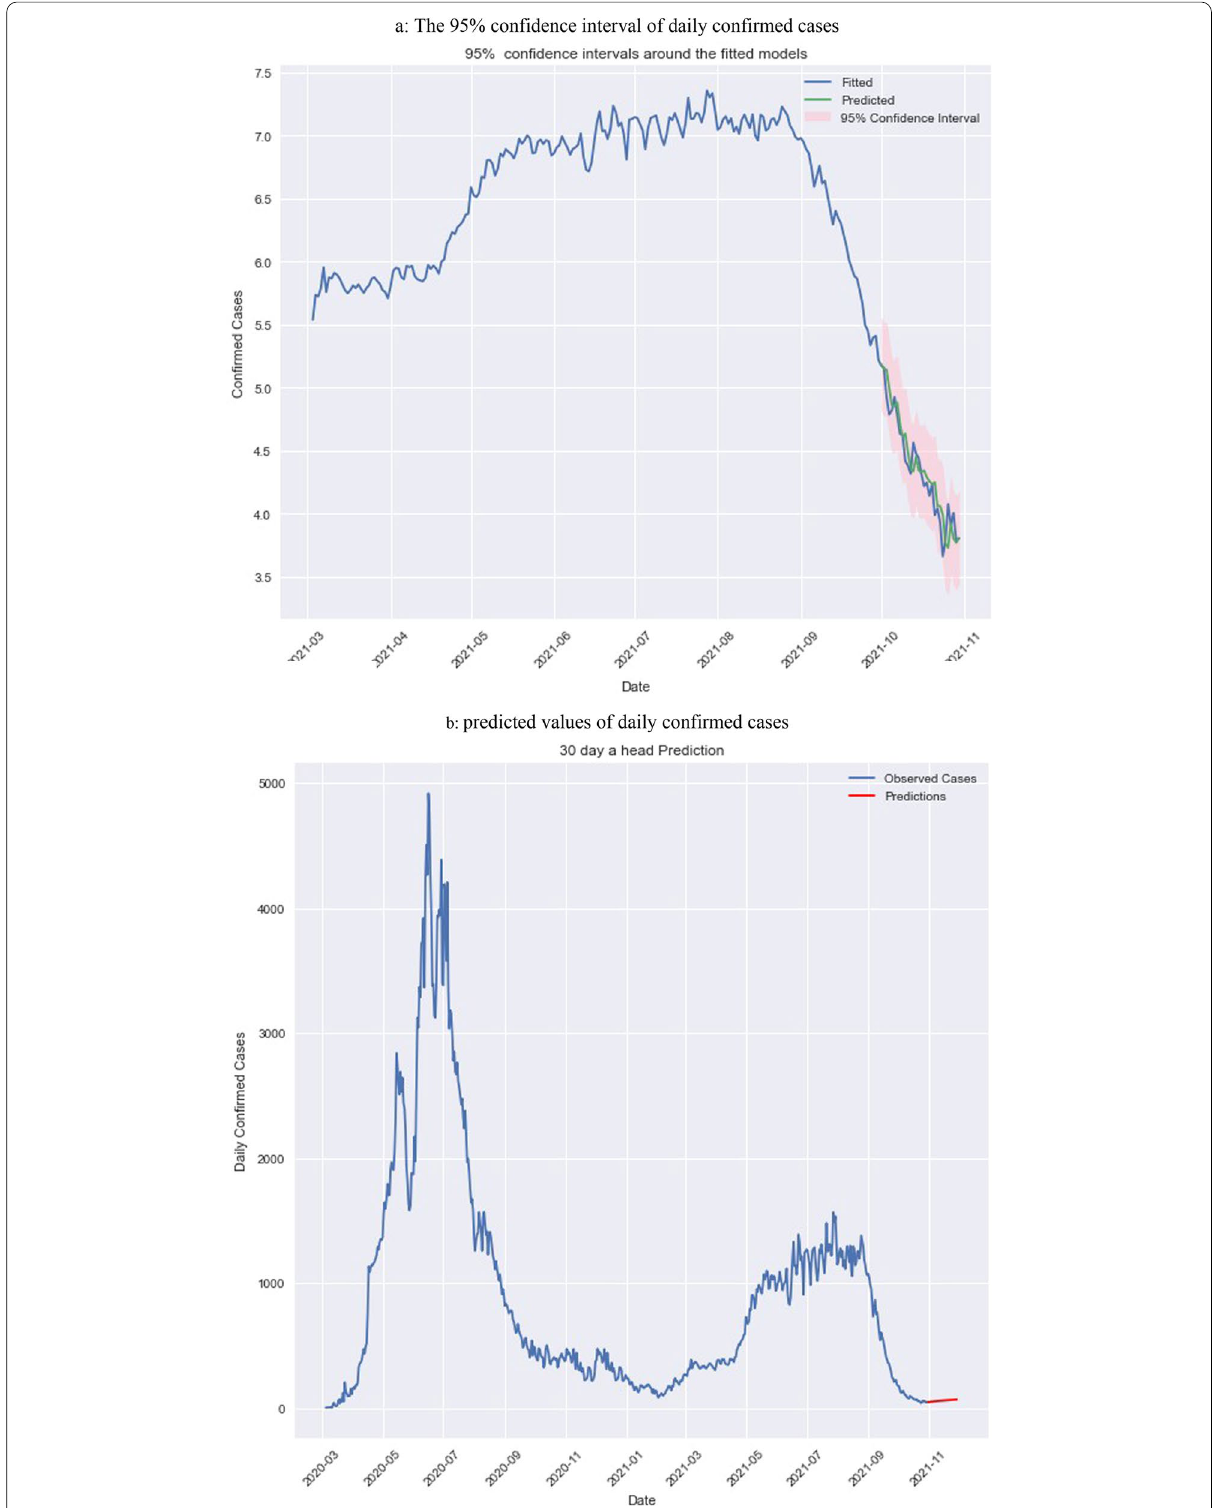
Fig. 3 ( a) The 95% confidence interval of daily confirmed cases. ( b ) Predicted values of daily confirmed